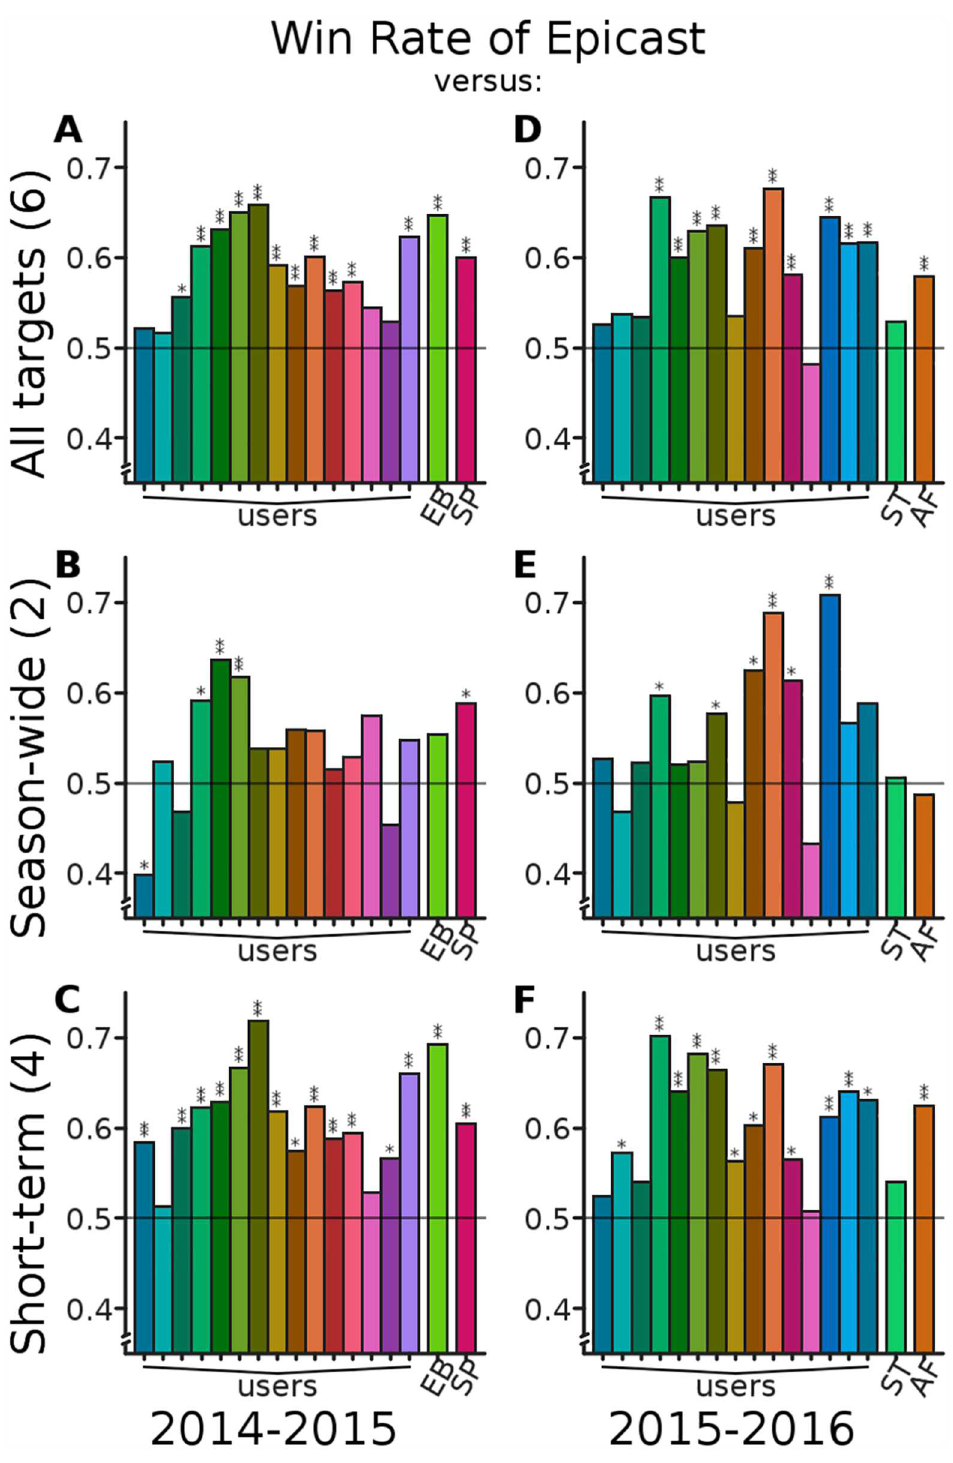
Fig 5. Epicast Win Rate against individuals and competing systems. All plots show, for each predictor (users participatingon at least half of the weeks and statistical systems Empirical Bayes (EB), PinnedSpline (SP), Stat (ST), and ArcheFilter (AF)), Win Rate: the fraction of instanceswhere Epicast had lower absolute error than the competitor, across all regionsand lead times ( n 2014 = 231, n 2015 = 176 per target). A Win Rate abovethe reference line of 0.5 impliesthat Epicast had lower absoluteerror more frequently than the